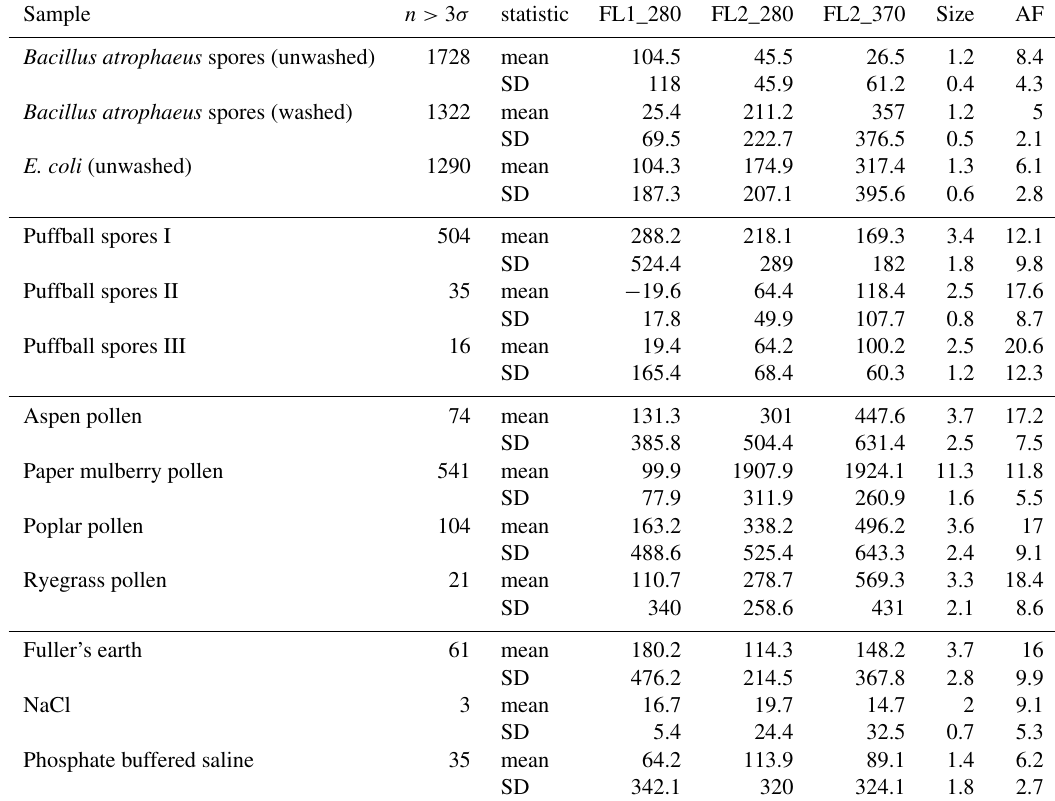
Table C3. Summary of particle measurements for the 2014 data set using a fluorescent threshold of 3 σ